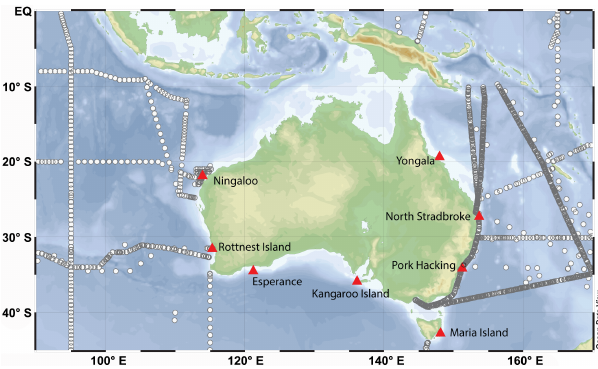
Figure 1. Locations (circles) of the concomitant measurements of alkalinity and salinity used to develop a new salinity–alkalinity re- lationship for the Australian region; the cruises are listed in Table 1. Overlain on this plot (red triangles) are the locations of IMOS Na- tional Reference Stations (NRS) used in this